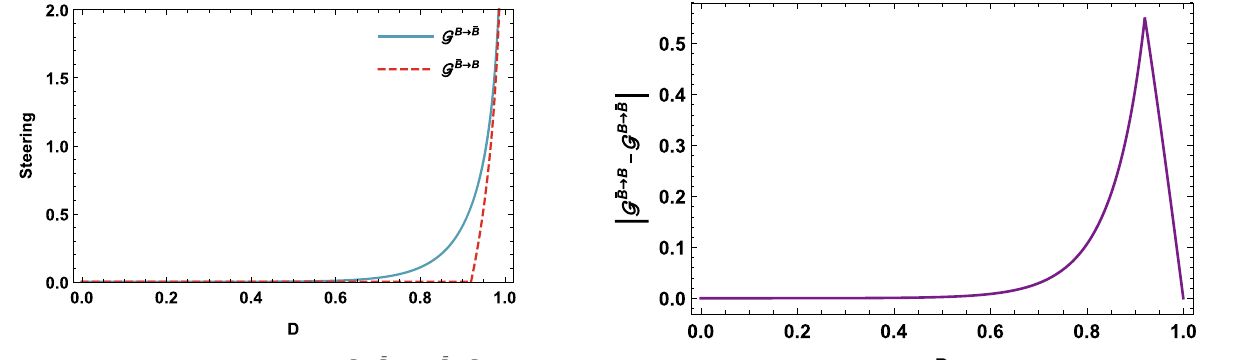
Fig. 3 The Gaussian quantum steerability G B → tion of the dilaton parameter D of the GHS dilaton black hole. The initial squeezing parameter, mass parameter and frequency ω are fixed as s = 1, M = 1 and ω = 0 . 5 respectively